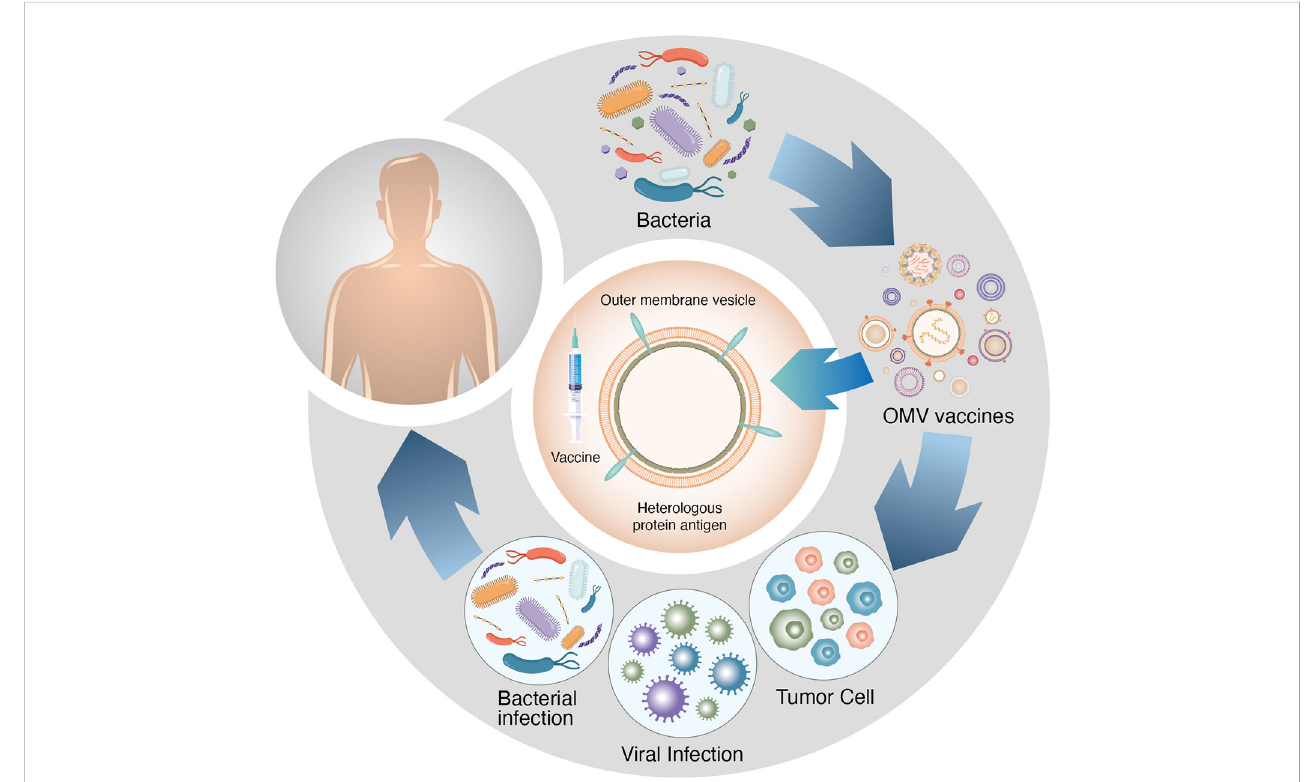
FIGURE 5 OMV vaccines play important roles in immunotherapy against various gastrointestinal